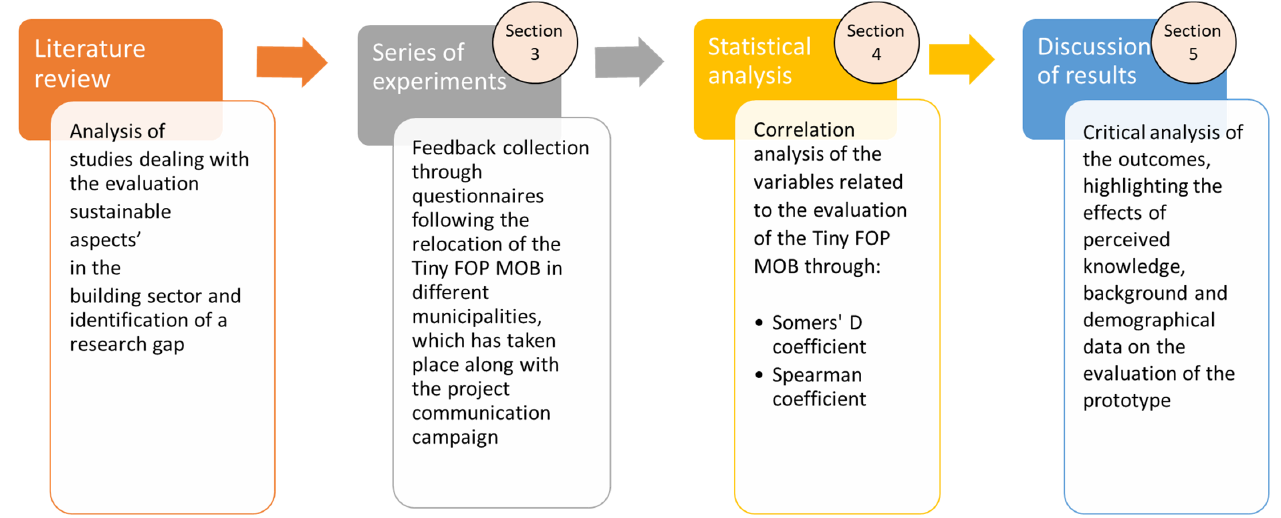
Figure 1. Research procedure schematised into steps and the following sections mostly devoted to illustrating such steps. illustrating such